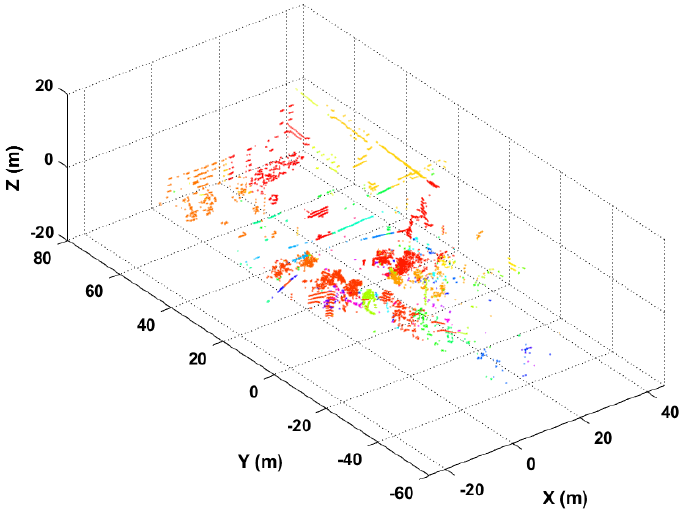
Figure 6. Point Cloud Clustered Based on Euclidean Distance.